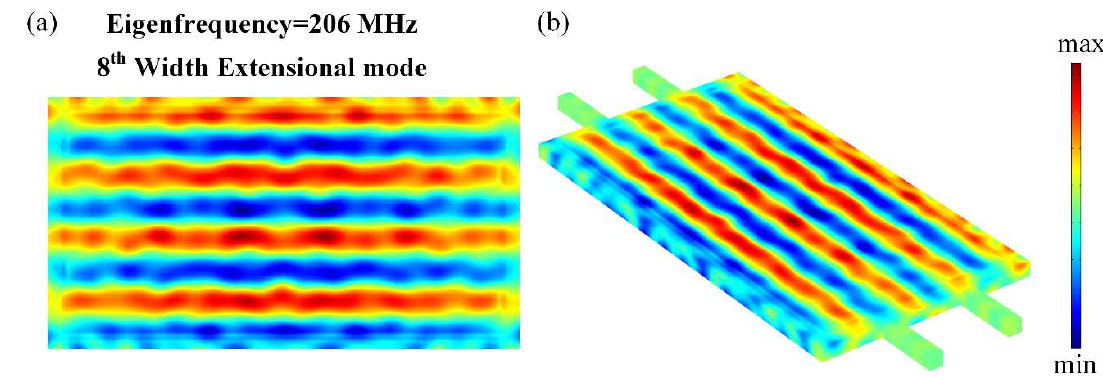
Figure 3. FEA (finite-element analysis) simulations were performed for the systematical investigation of the designed resonator. ( a ) is the displacement mode shape of the proposed resonator working in high order width-extensional (WE) vibration mode. It can be noticed from the displacement contour that the resonator was working in 8th-order width-extensional vibration mode and this fit the requirement of even-order. The support beams were positioned at the nodal points where the displacements were almost zero, as shown in ( b ).